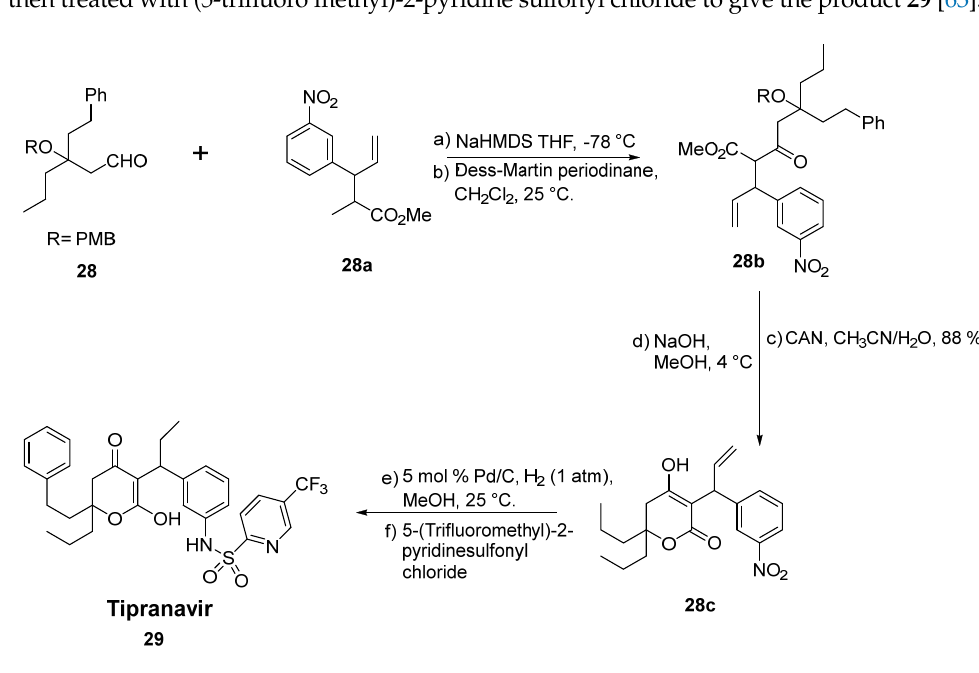
Figure 16. Synthesis and structure of